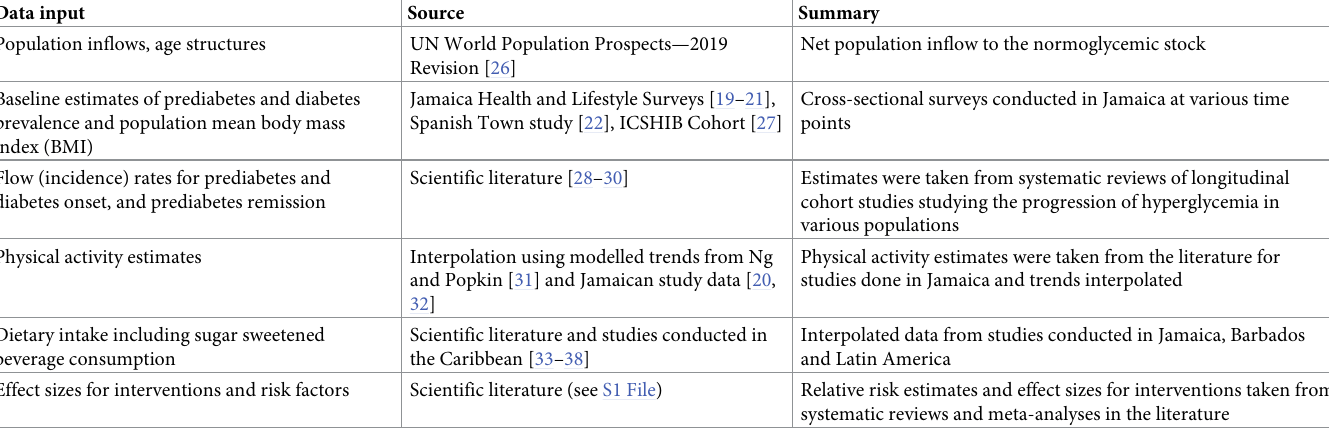
Table 1. Key data inputs �